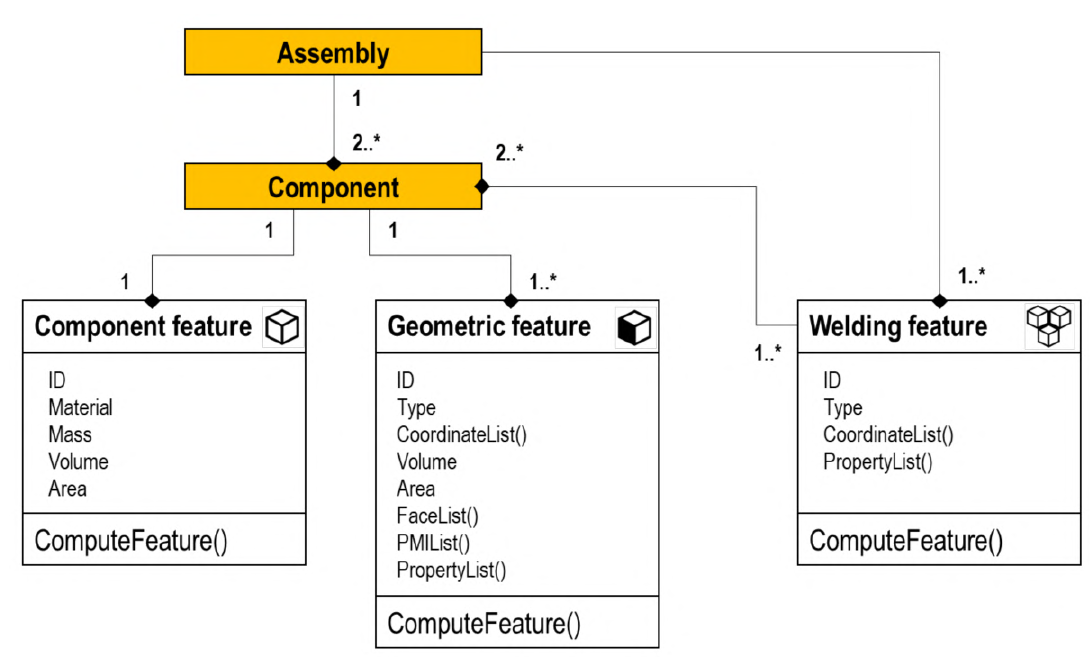
Figure 4. Feature recognition framework (class diagram).